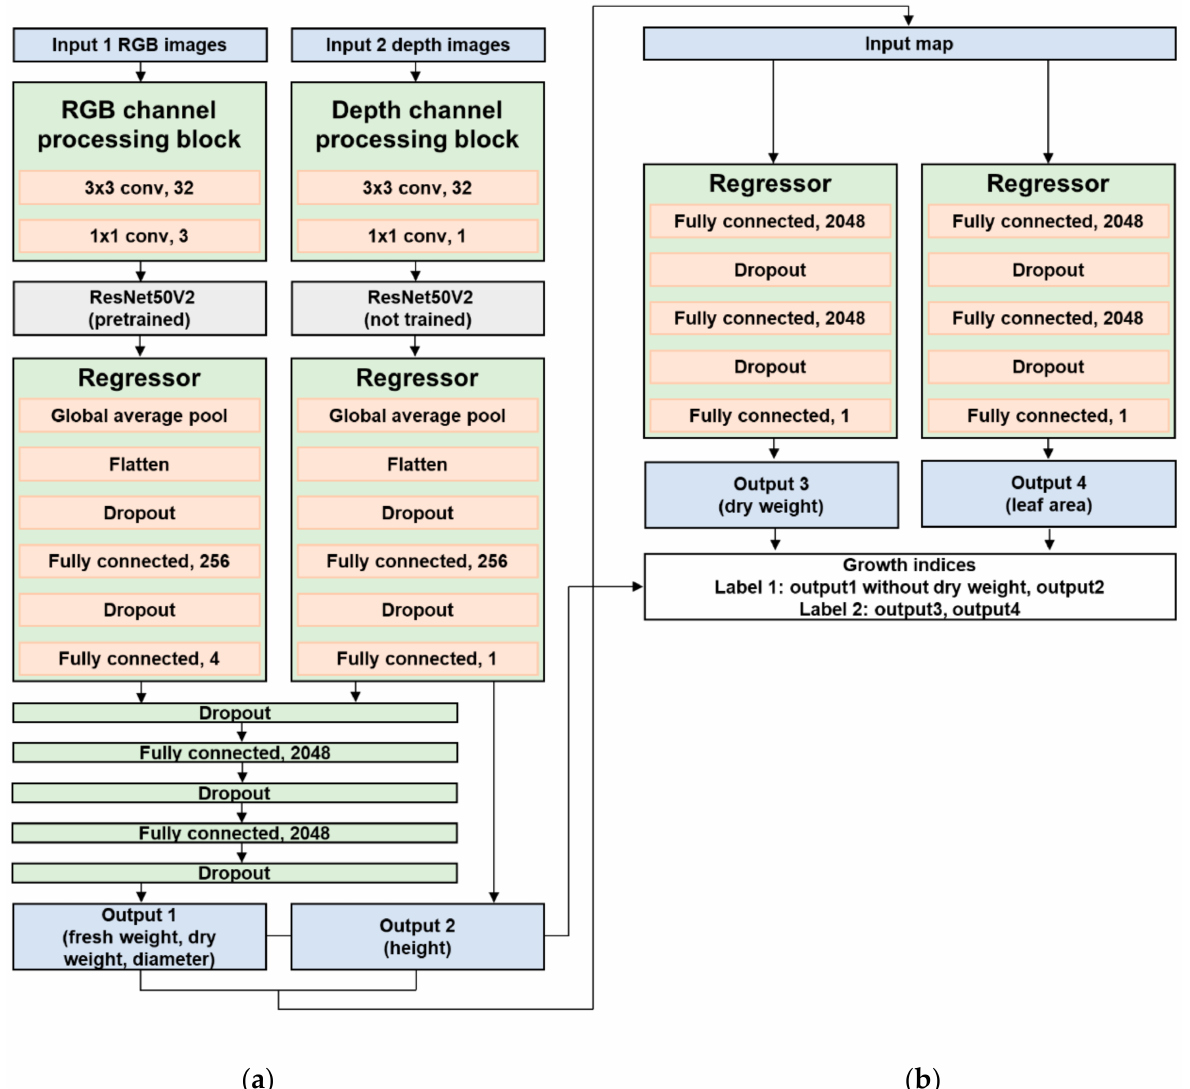
Figure 4. Two-stage architecture. ( a ) First stage: parallel RGB and depth input models based on untrained ResNet50V2 to estimate fresh weight, dry weight, diameter, and height. ( b ) Second stage: parallel artificial neural network regression model to estimate the dry weight and leaf area.